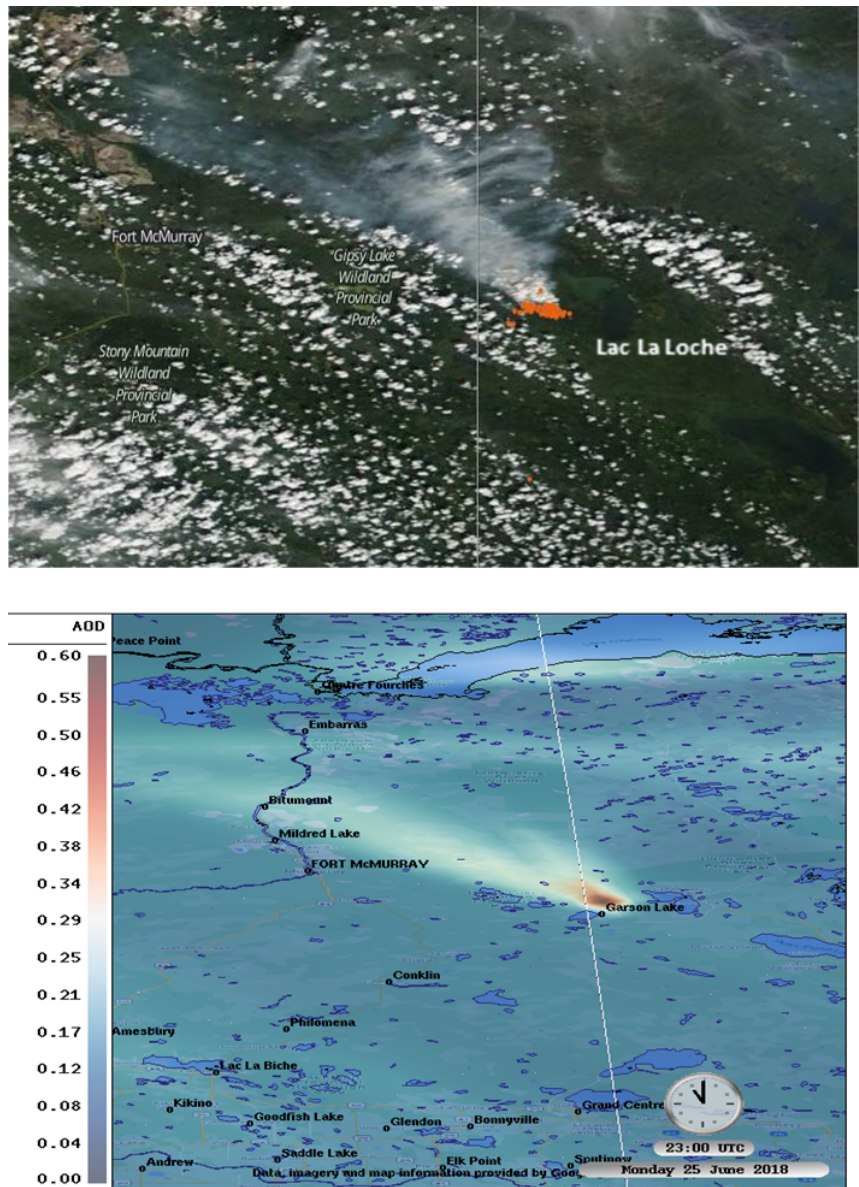
Figure 13. Lac La Loche forest fire on 25 June 2018. Top: overlay layer: MODIS Terra thermal anomalies (day and night), over MODIS Terra true color corrected reflectance (image from https://worldview.earthdata.nasa.gov, last access: 1 June 2021). Bottom: GEM-MACH AOD at 580nm at